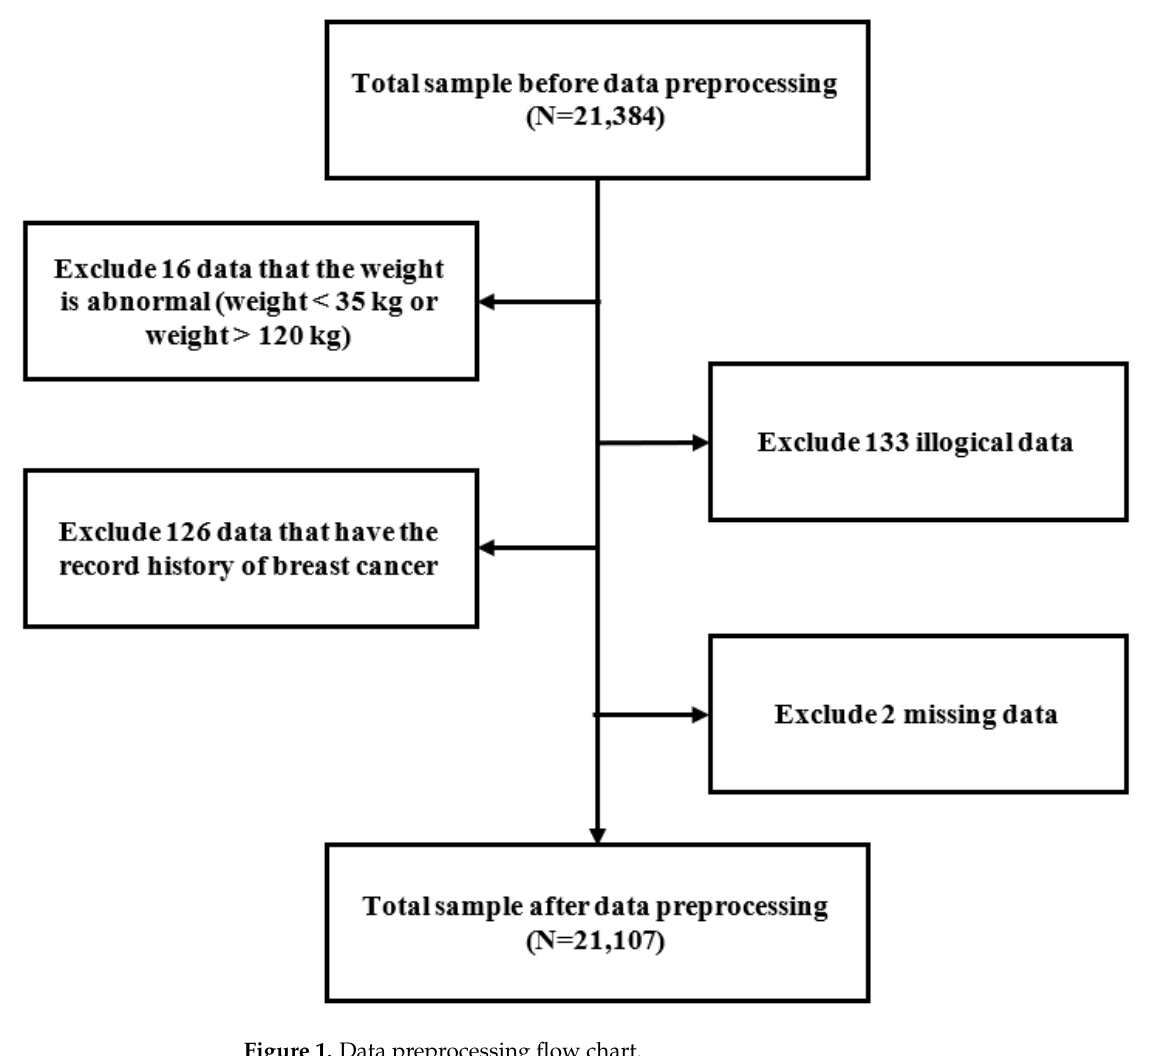
Figure 1. Data preprocessing flow chart.